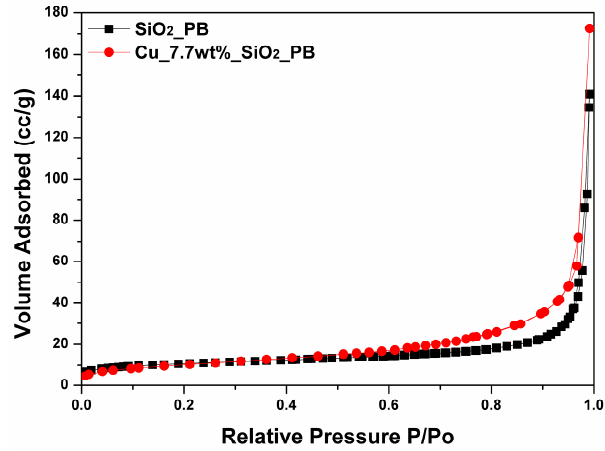
Figure 5. Isotherm plots of samples SiO 2 _PB (black line) and Cu_7.7 wt %_SiO 2 _PB (red line).